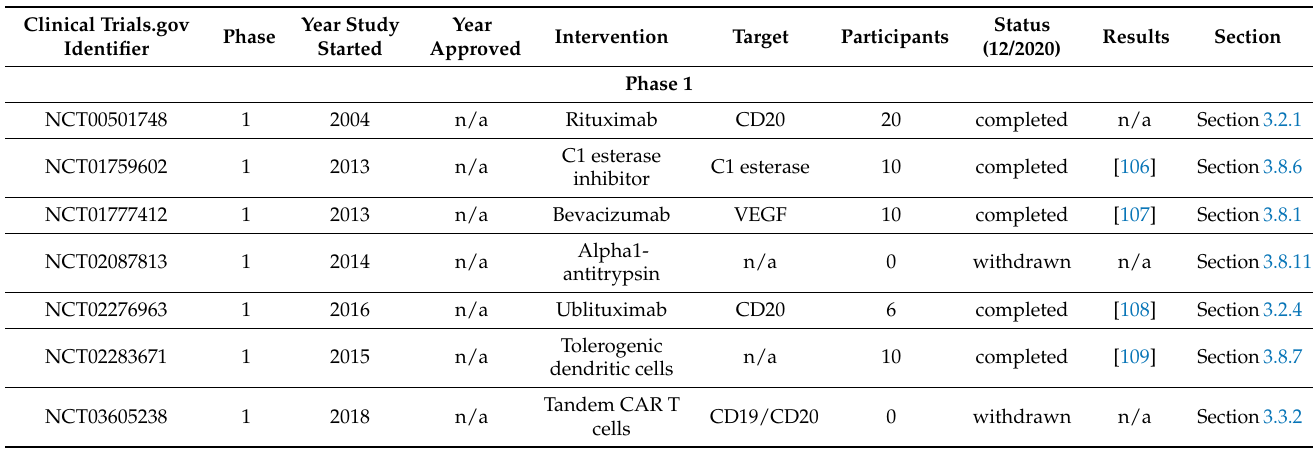
Table 1. Interventional clinical studies including neuromyelitis optica spectrum disorders (NMOSD) patients as listed on clinicaltrials.gov ( accessed December 2020 ). APRIL = A proliferation-inducing ligand; BAFF = B cell activating factor; BTK = Bruton’s tyrosine kinase; C1 = complement factor 1; C5 = complement factor 5; CAR = chimeric antigen receptors; CD = cluster of differentiation; H1 = histamine receptor 1; IL-6 = interleukin-6; K + = potassium; VEGF = vascular epithelial growth